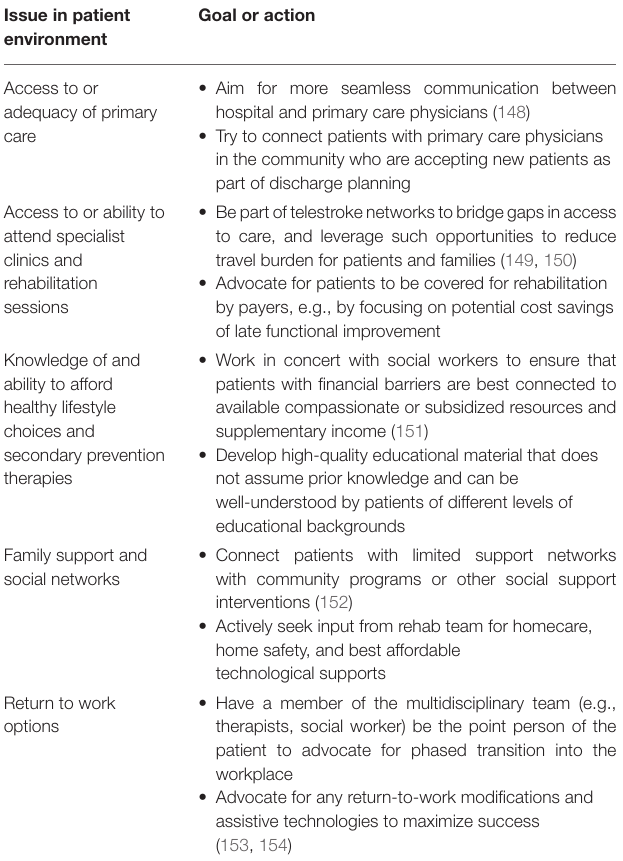
TABLE 3 | Psychosocioeconomic action items for stroke teams to address or advocate for between 3 months and 5 years post-stroke to help maintain EVT